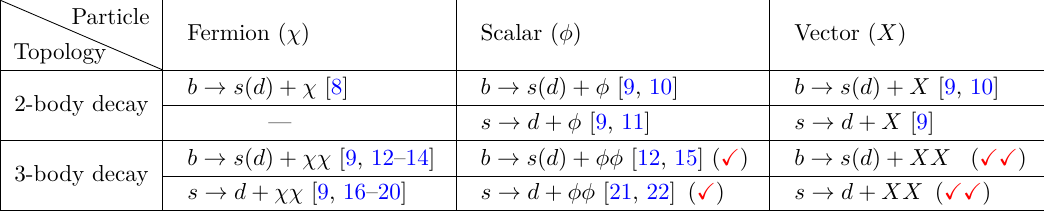
Table 1 . List of possible b → s ( d ) + /E and s → d + /E modes related to B and K meson decays: a “ XX ” means that they have not been studied before while a “ X ” indicates they have been partially studied, both are the subject of this